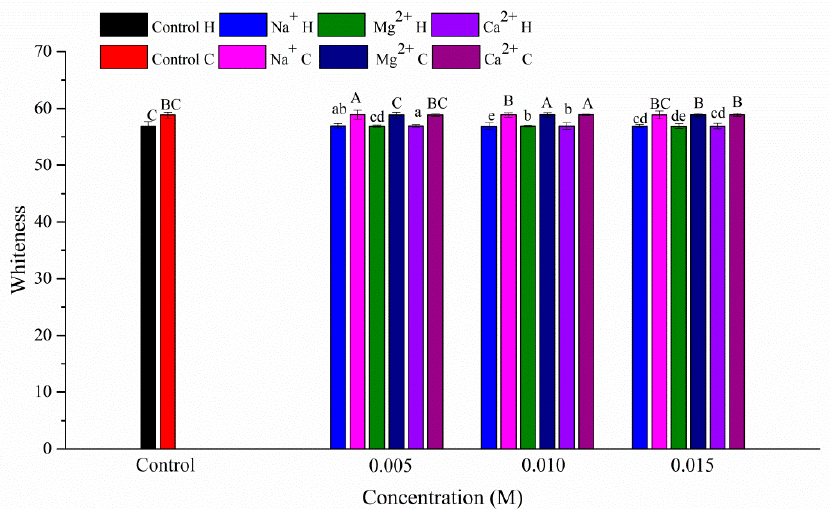
Figure 2. Effect of salt ions before spray drying on the whiteness of soy protein isolate heat- and cold-induced samples. All sample values are average values ± standard deviation ( n = 3), and different letters in the same figure represent a significant difference between samples ( p < 0.05). Capital letters represents cold-induced gels and lower case letters represents heat-induced gels. C represents cold-induced gels; H represents heat-induced gels.